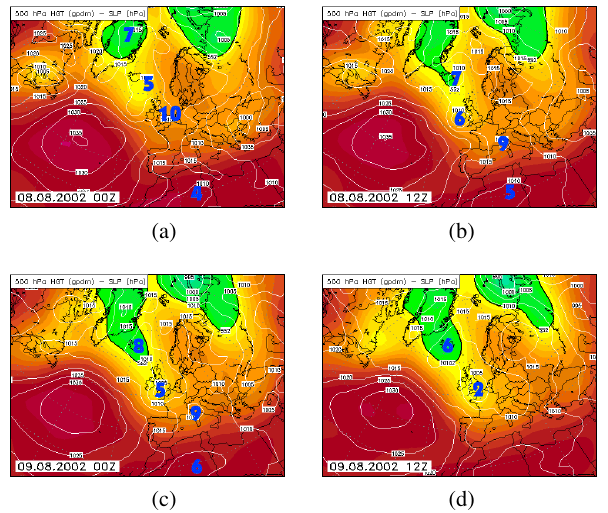
Figure 7. Example of a sequence of summer days: Sea level pres- a sequence of summer days: Sea level pressure field on 8 and 9 August, 2002 (white lines). A selection Figure 7 : Example of sure field on 8 and 9 August 2002 (white lines). A selection of of identified cyclone centers are numbered in blue. identified cyclone centers are numbered in blue.